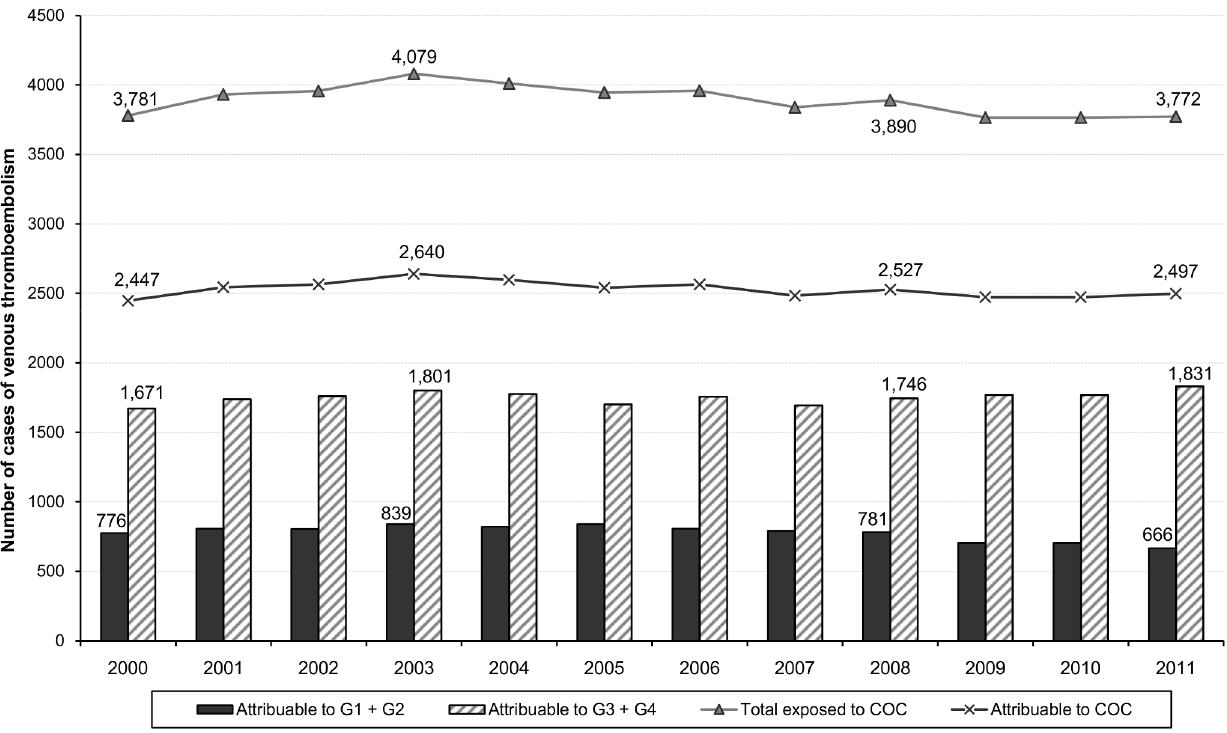
Figure 2. Number of cases of venous thromboembolism annually attributable to combined oral contraceptives. The figure shows the number of cases attributable to combined oral contraceptives overall and by generation in France from 2000 to 2011.